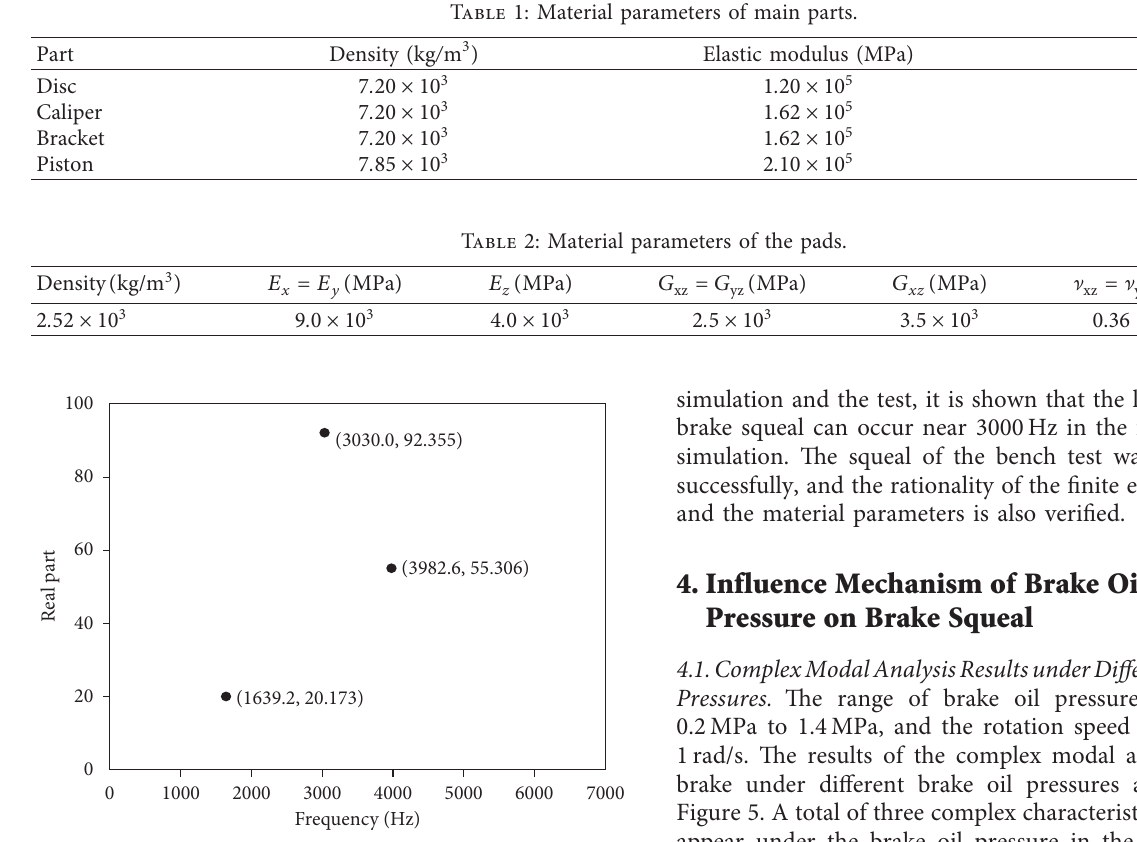
Figure 3: Result of complex modal simulation under 0.8 MPa oil